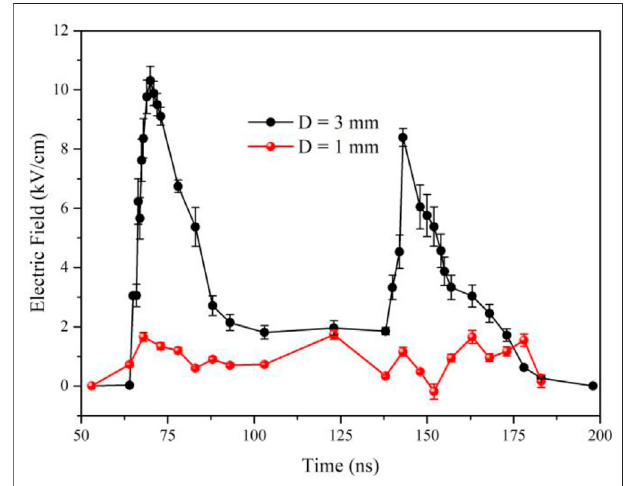
FIGURE 8 | Calibration curve of the electric fi eld and square of the second-harmonic signal.